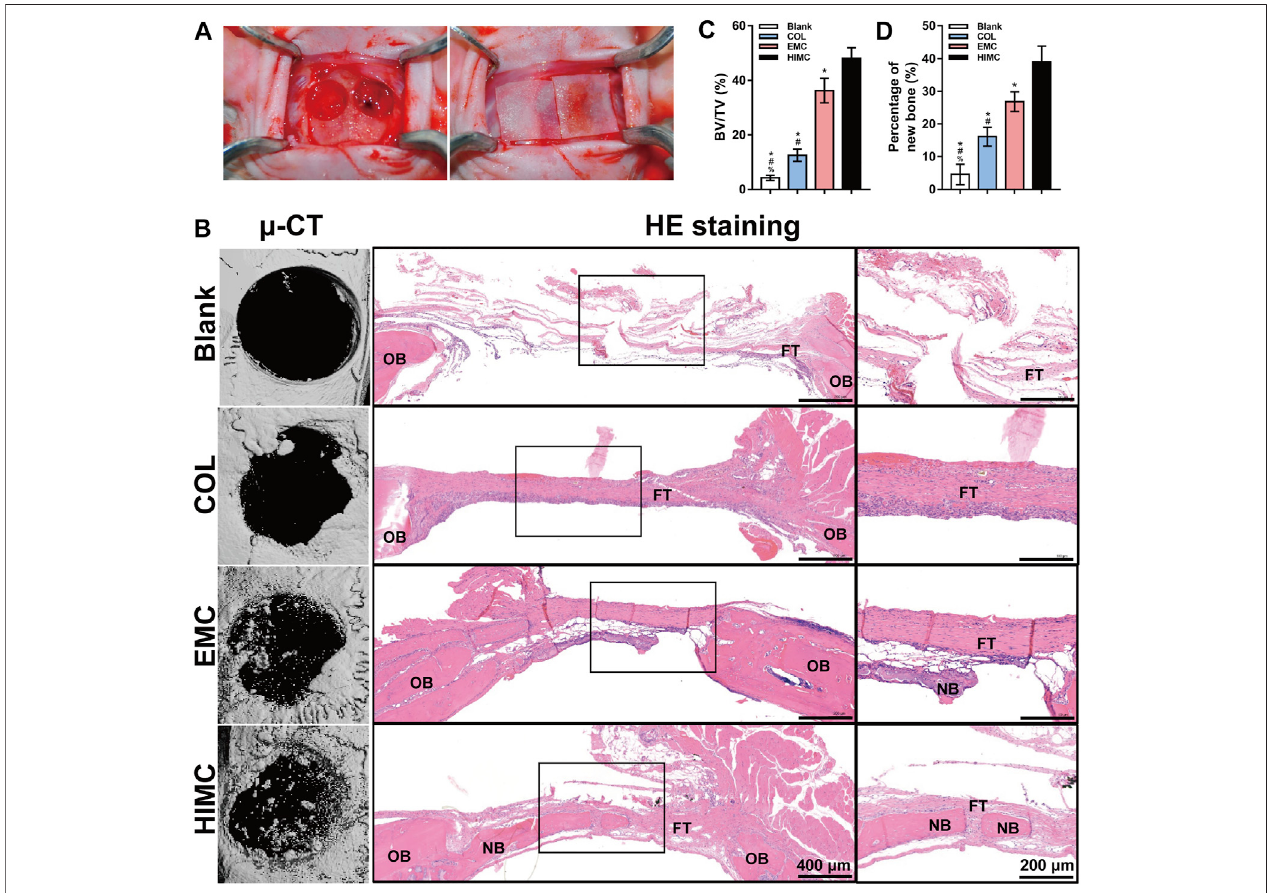
FIGURE 5 | Bone regeneration in rat critical-sized skull defect models covered with the different membranes. (A) Rat critical-sized cranial defect models. (B) Representative μ -CT images, HE staining images, and ×40 magni fi cation images of the regions outlined by black rectangles at 12 weeks post-surgery. (C) Quantitative analysisofnewBVrelativetothe TVonthebasisof μ -CT. (D) Semi-quantitativeanalysisofthepercentagesofnewbonein thedefect accordingtoHE staining. Dataare expressed as mean ± SD. Scale bar, 400 μ m (20×) and 200 μ m (40×). * p < 0.05 vs. HIMC membrane; # p < 0.05 vs. EMC membrane; % p < 0.05 vs. COL